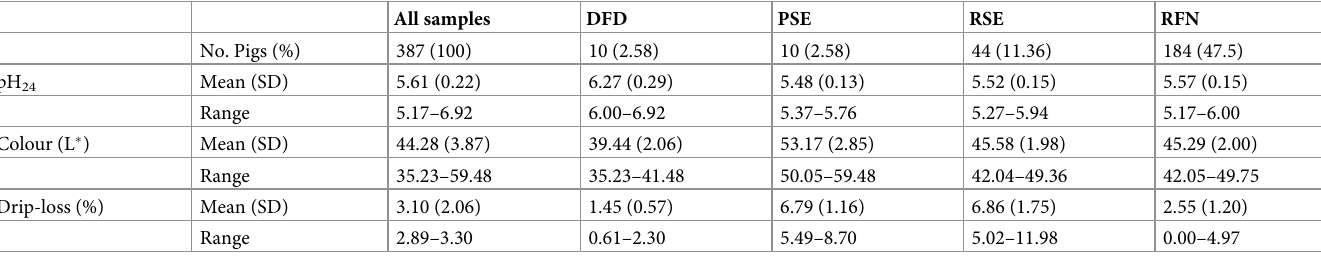
Table 5. Summary of technological meat quality attributes for all the categories of Pork. All samples DFD PSE